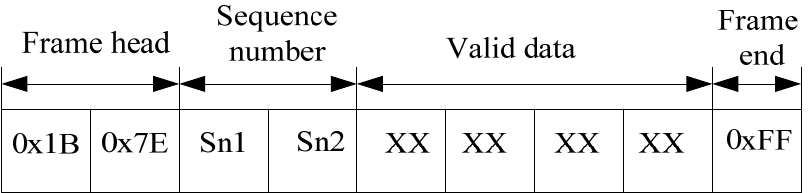
Figure 5. Wireless communication